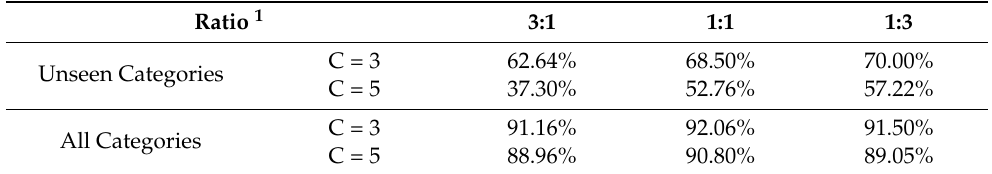
Table 4. Recognition accuracies under the conditions of different unseen category proportion during